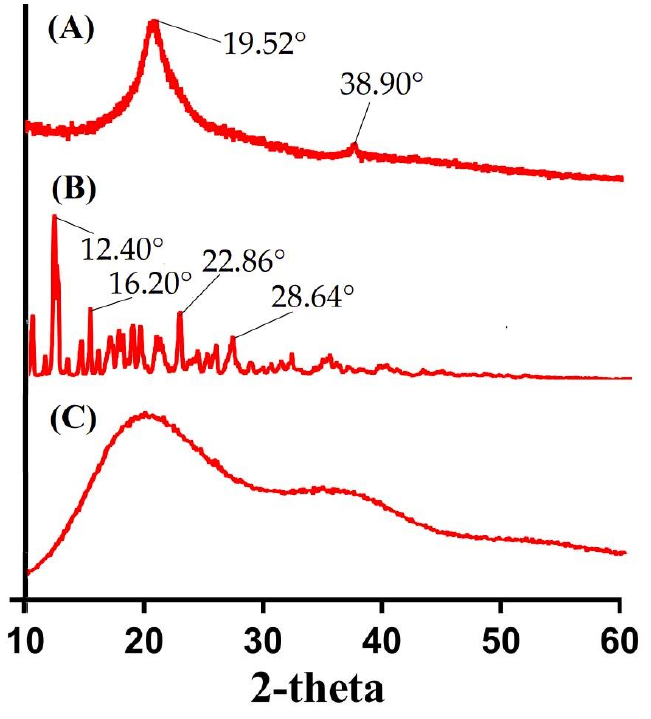
Figure 5. PXRD of ( A ) CS, ( B ) β -CD, and ( C ) CS/ β -CDcPAa hydrogel.